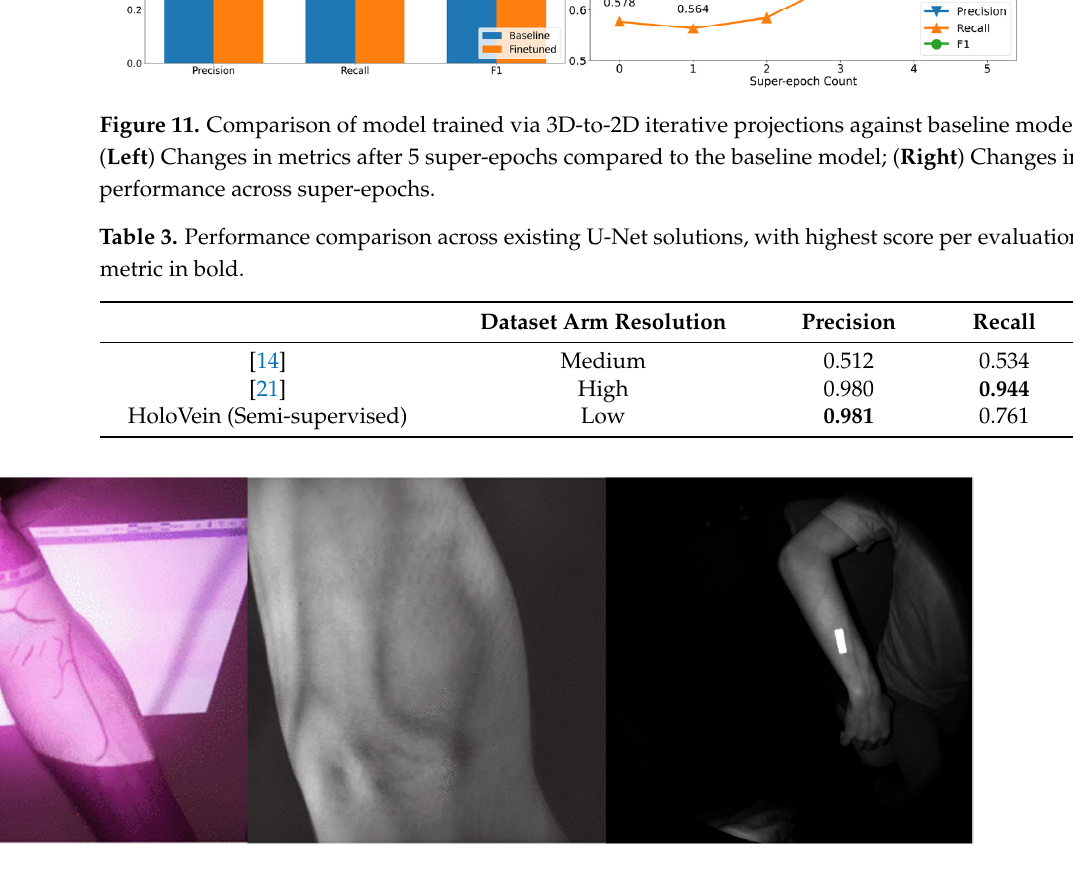
Figure 12. Comparison between typical arm/vein views for different vein detection systems, in [14,21] and ours from left to right, with images from prior work extracted from original papers and the right-most image showing the typical view from a head-worn setup. All images are of 512 × 512 resolution.